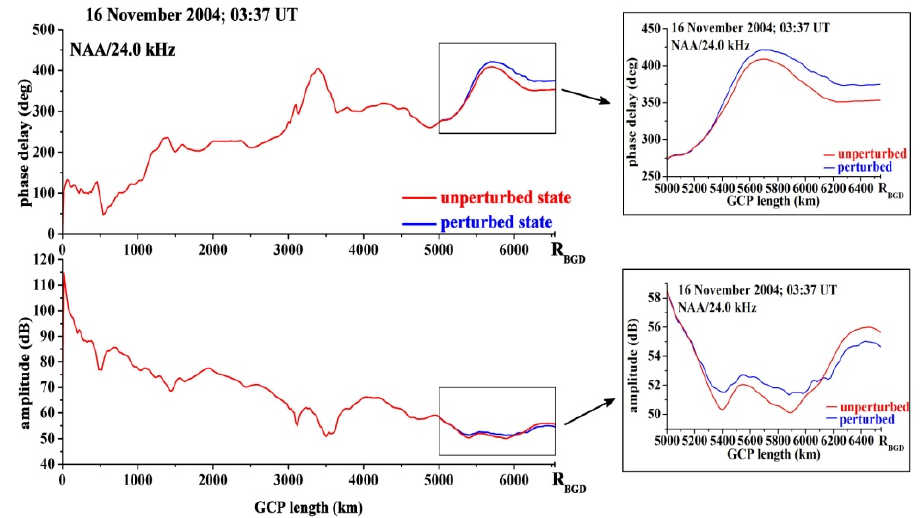
Figure 6. Simulated amplitude and phase delay along GCP path towards the Belgrade receiver, for unperturbed (red) and perturbed (blue) ionospheric states for NAA/24.0 kHz VLF signal waveguides, on 16 November 2004.